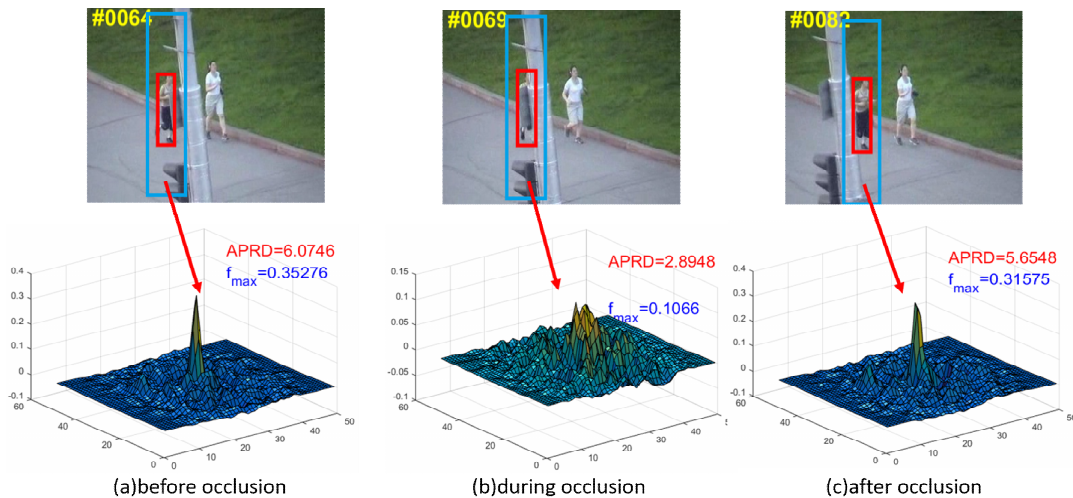
Figure 4. The first row are the shots of the sequence Jogging from OTB2013, where the red and blue bounding box denote the target and the searching area of FEDCF, respectively. The second row are response maps corresponding to the scenario above. ( a ), ( b ) and ( c ) respectively show the scenarios before occlusion, during occlusion and after occlusion.